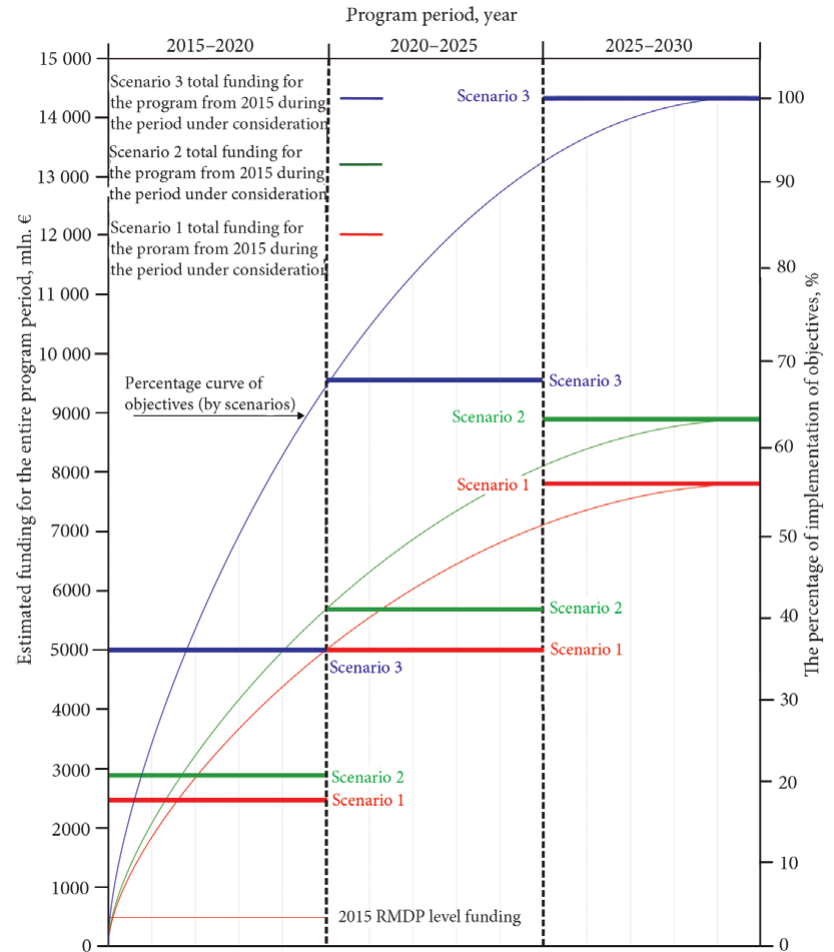
Fig. 6. RMDP funding scenario